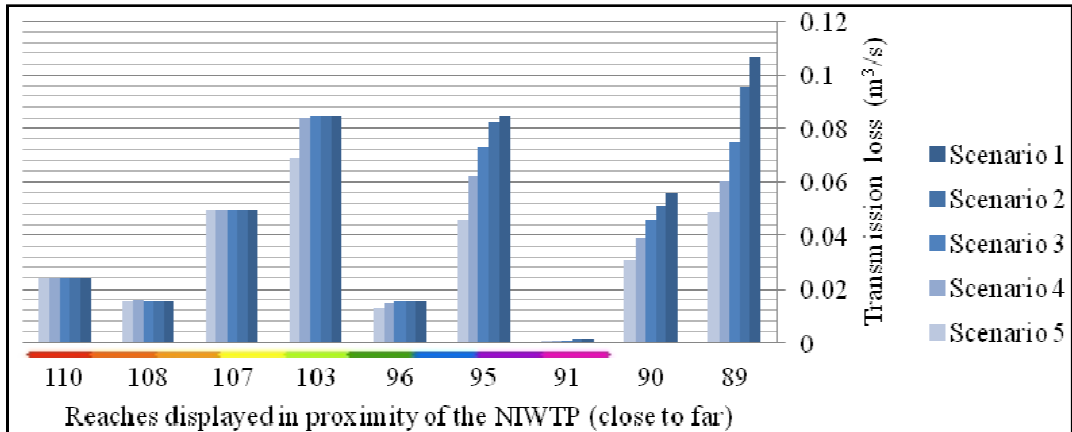
Figure 6. Column chart portraying predicted transmission losses (cubic meters per second; cms) at each reach, for varying scenarios [49], where Scenario 1 is current day or 15 MGD, Scenario 2 is 12.5 MGD (83%), Scenario 3 is 10 MGD (67%), Scenario 4 is 7.5 MGD (50%) and Scenario 5 is 5 MGD